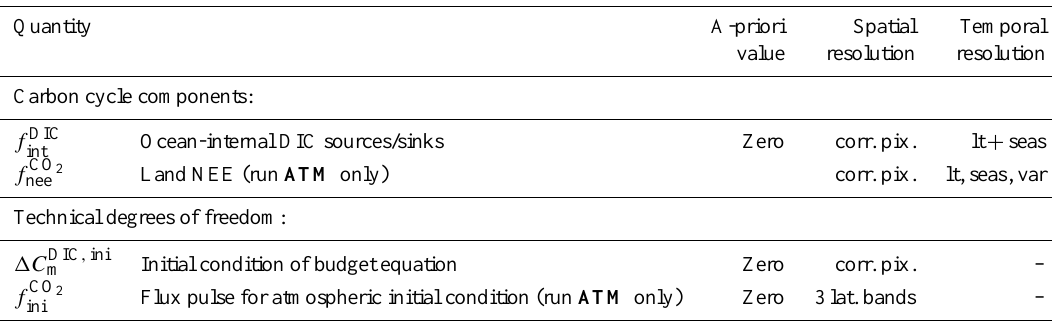
Table 4. Adjustable degrees of